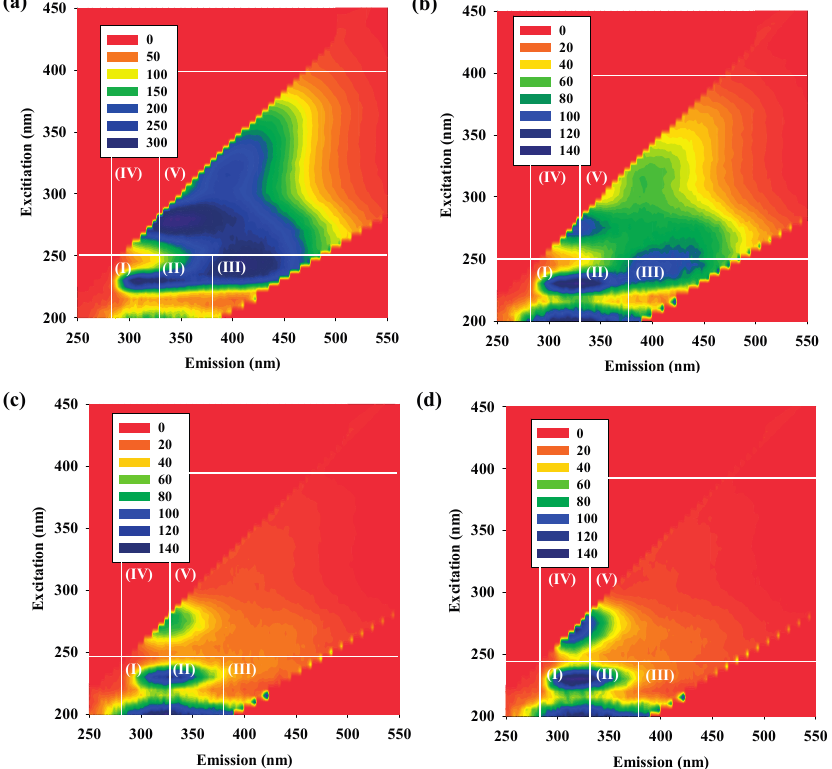
Figure 3. Representative fluorescence EEM spectra of DOM for ( a ) raw water and water treated with ( b ) ozonation, ( c ) catalytic ozonation ( α -FeOOH, 0.5 g·L − 1 ) and ( d ) catalytic ozonation ( α -FeOOH, 1.5 g·L − 1